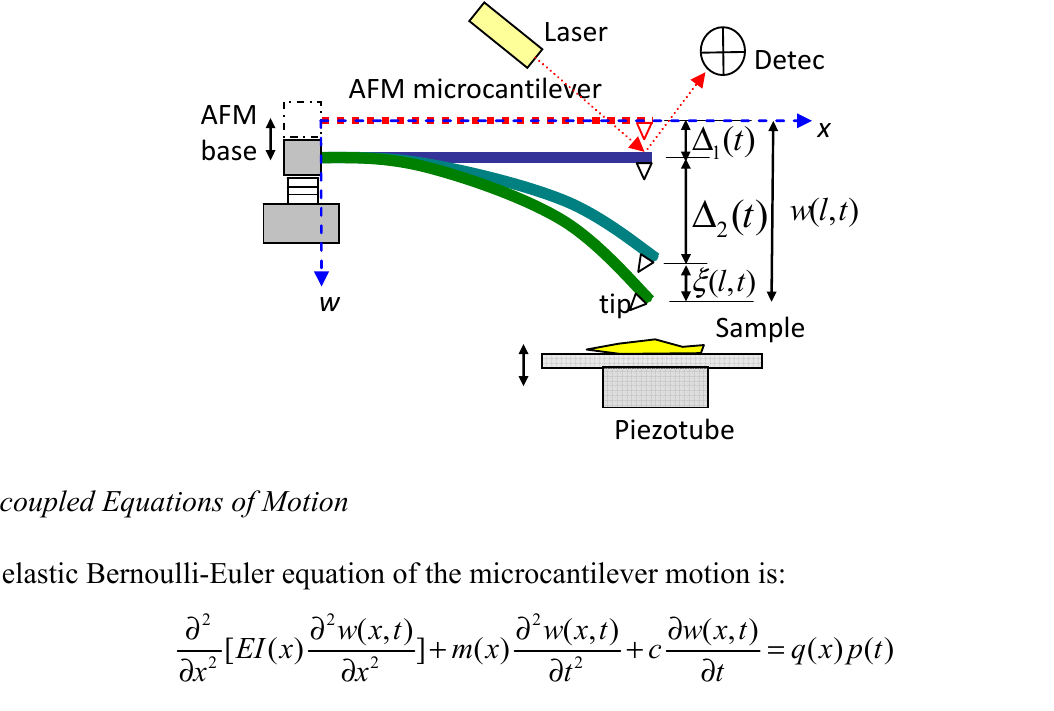
Figure 1. Schematics of the deflection of AFM microcantilever. Δ ( t ) is static deflection caused by deflection dependent tip-end force, and AFM base, Δ 2 ξ ( l , t ) is the dynamic deflection caused by the surface homogeneous